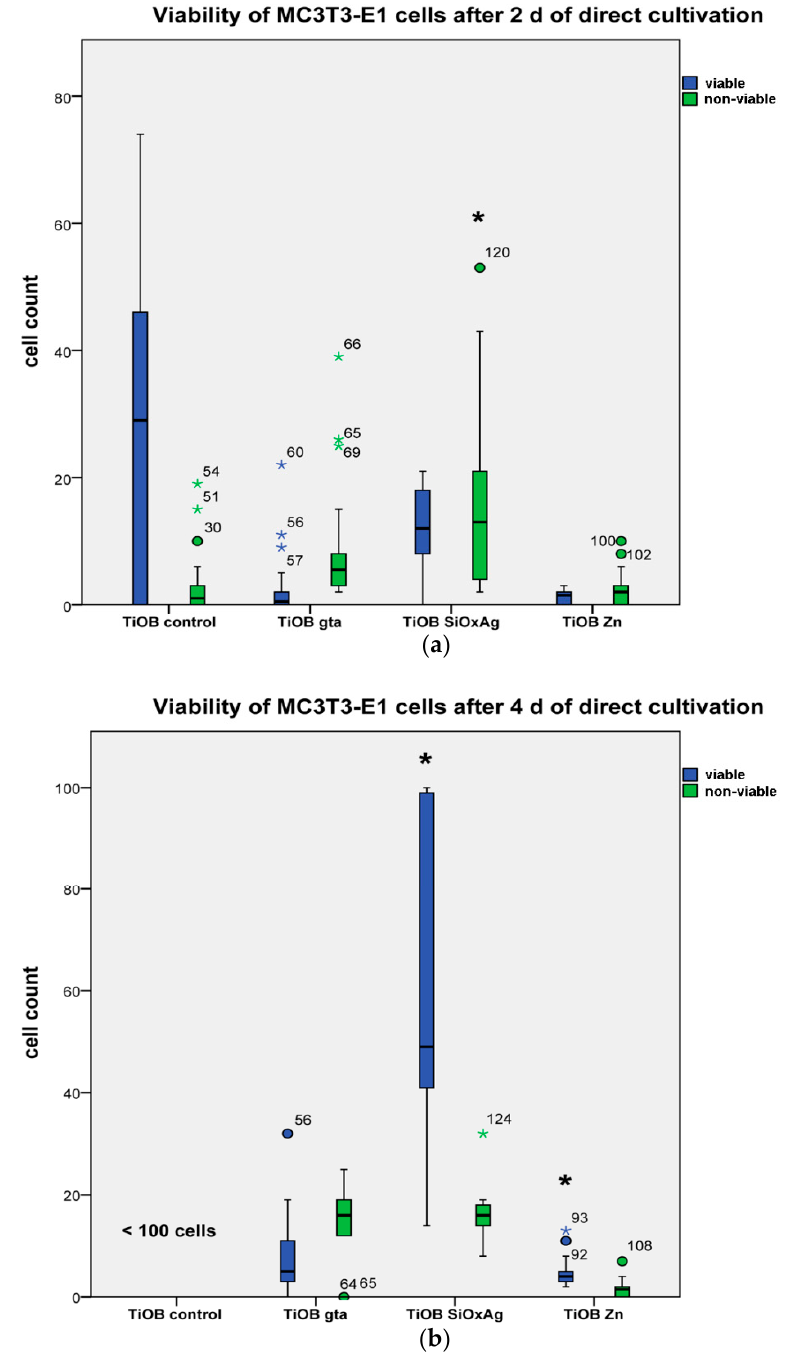
Figure 6. Share of viable and non-viable cells grown in direct contact with non-functionalized TiOB ® (TiOB ® control), TiOB ® gta, TiOB ® SiOx Ag, and TiOB ® Zn after 2 ( a ) and 4 ( b ) days of cultivation. Significant differences are marked with a star ( p < 0.05).